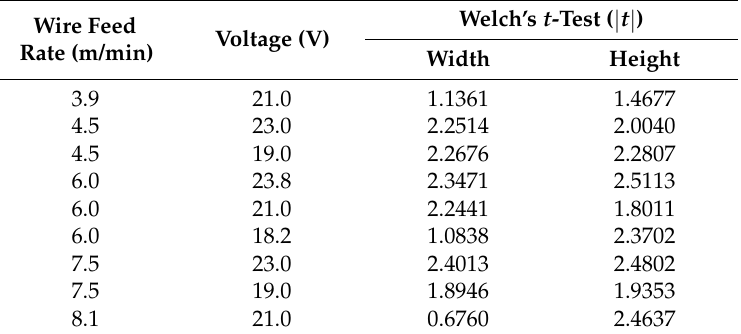
Table 3. Welch’s t -test computed for measurements of width and